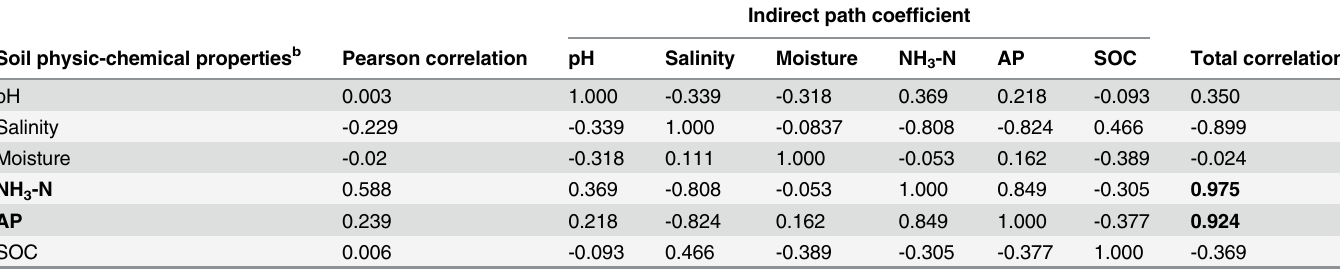
Table 4. Path analysis between SMR a and basic physical and chemical